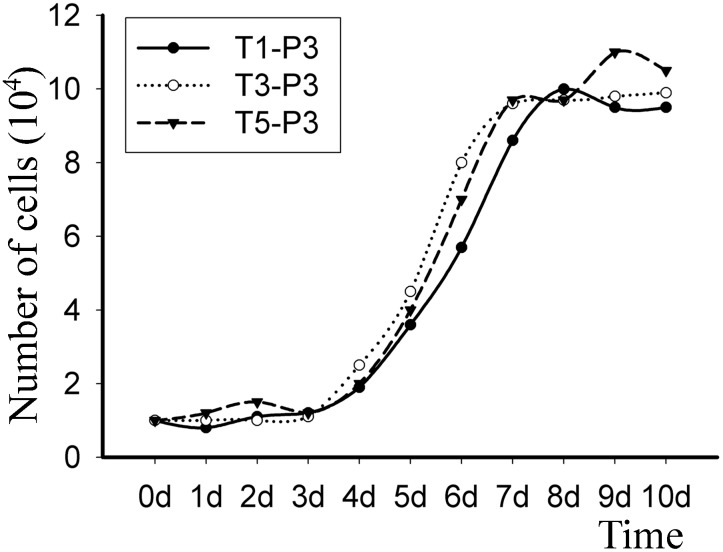
Growth curves of the T1-P3, T3-P3 and T5-P3 hUCMSCs.The growth curves demonstrate the number of days that the cells were in the lag, log and stationary phases of growth.